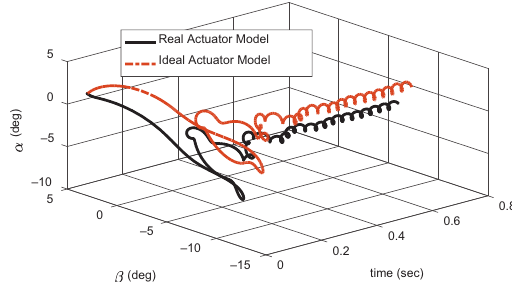
Figure 5. Three-dimensional angular motion in presence of real and ideal ON-OFF actuator